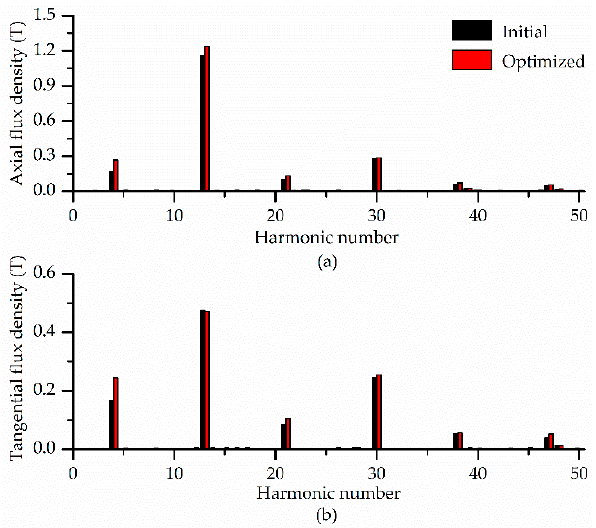
Figure 14. FFT analysis of the axial and tangential flux densities at the radius of R m4 in the LG of the HAMG. ( a ) Axial flux density; ( b ) Tangential flux density.